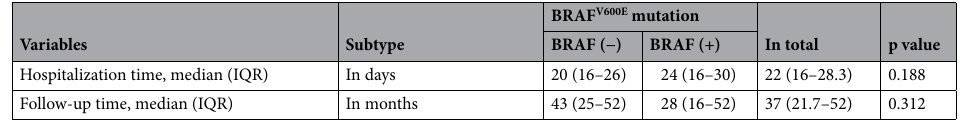
(AG), papillary glioneuronal tumor (PGNT) or polymorphous low-grade neuroepithelial tumor of the young (PLNTY) 1–3,5–7 . Interestingly, the new diagnosed entity of PLNTY may share the pathological characteristics with other types of brain tumors, including LEAT, oligodendroglioma, clear cell ependymoma, etc. However, molecular alterations, such as CD34 positive, lack of BRAF V600E mutation, IDH1/2 mutations and 1p19q codele- tion, may be helpful to differentiated these types of brain tumors 21 .